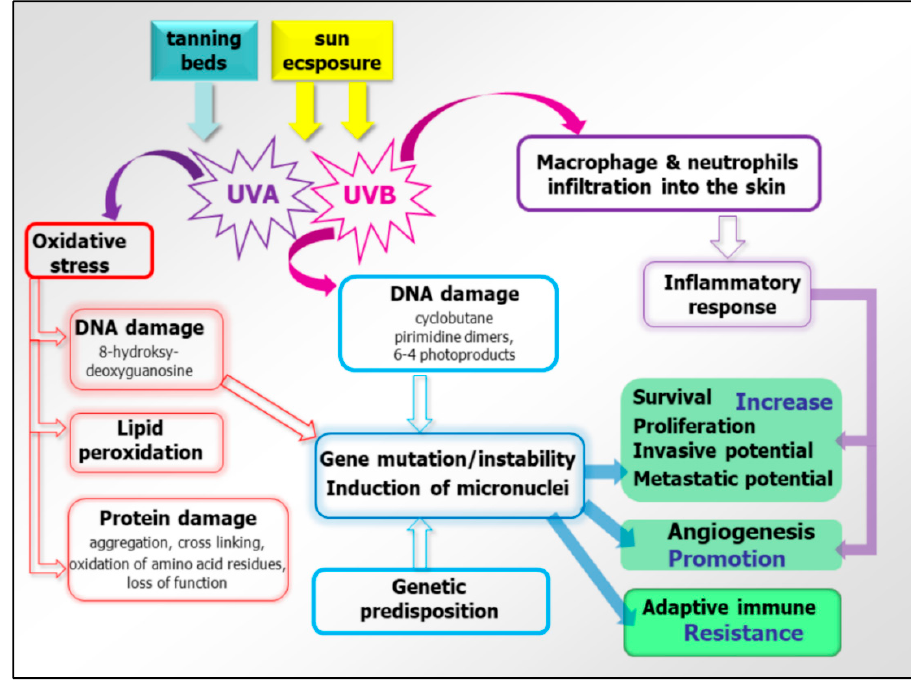
Figure 1. Molecular background of UV radiation and oxidative stress for the melanoma cause. Both sun exposure and tanning beds are sources of UV. Among them, UVA is mostly responsible for oxidative stress, causing DNA and protein damage as well as lipid peroxidation. DNA damage leads to gene instability and mutagenesis, impacting the main cellular processes involved in cancerogenesis, cancer growth, metastasis, and adaptive immune resistance. Likewise, UVB modulate those processes by the activation of inflammatory response.